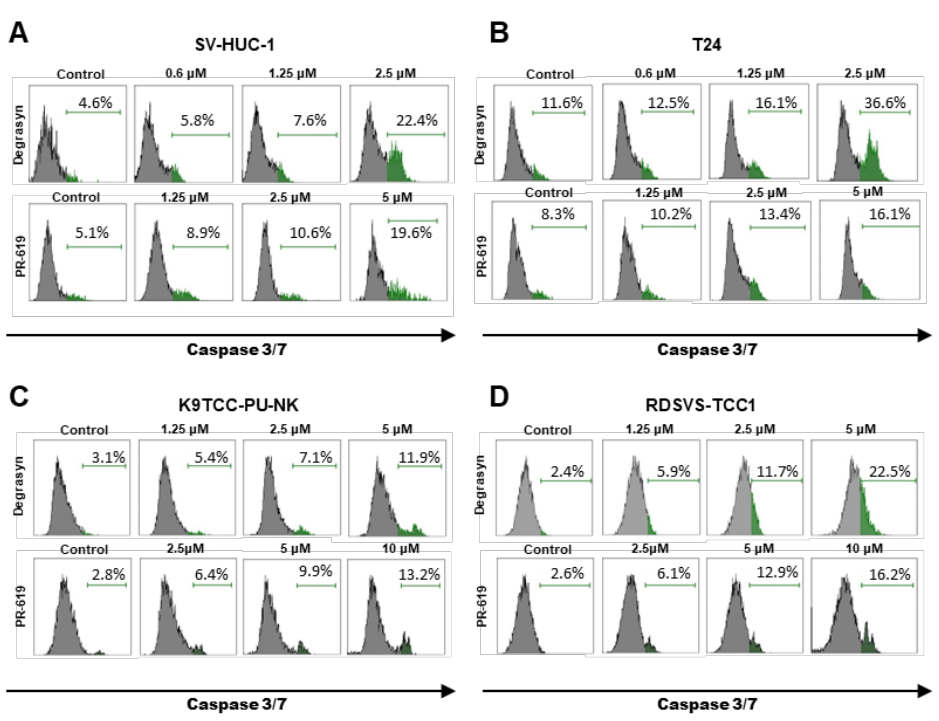
Figure 7 . Evaluation of caspase 3/7 activation induced by Degrasyn and PR-619. Representative histograms showing the percentage of cells stained with CellEvent ® Caspase-3/7 Green Detection Reagen after 24 h exposure to increasing concentrations of Degrasyn and PR-619 in ( A ) SV-HUC-1, ( B ) T24, ( C ) K9TCC-PU-NK, and ( D ) RDSVS-TCC cell lines.